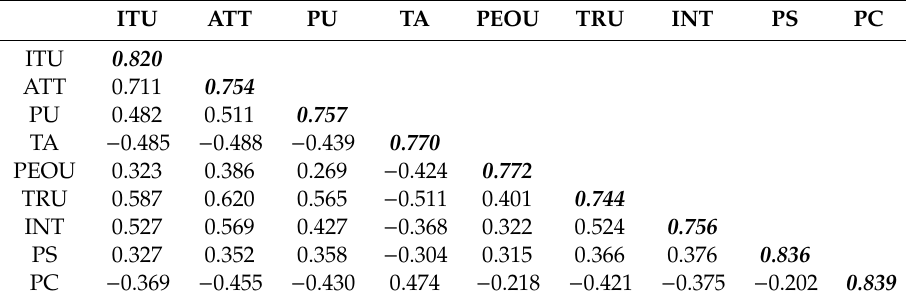
Table 4. Discriminant validity.